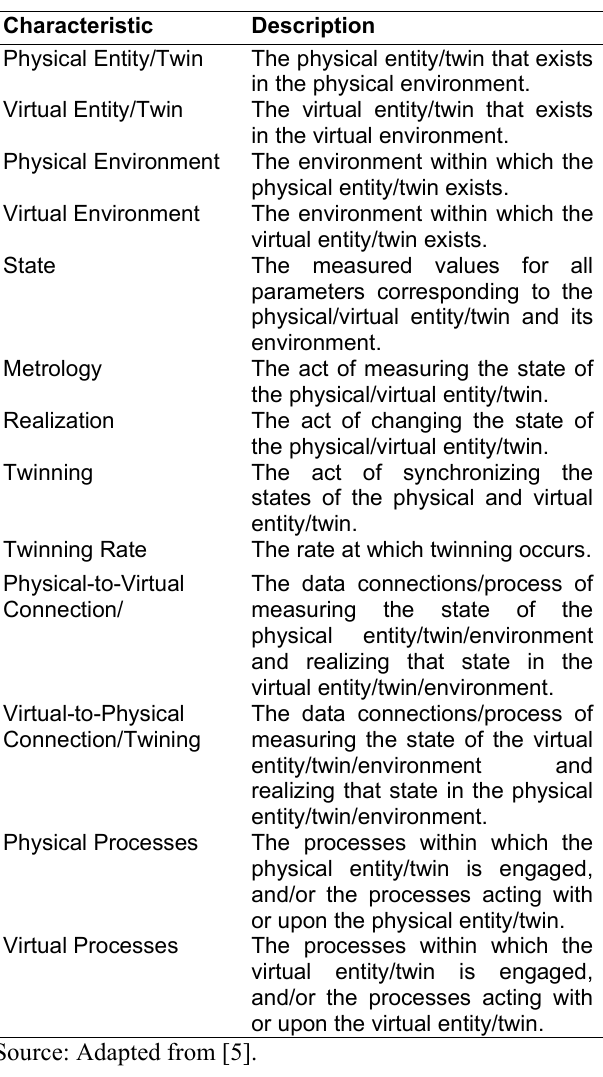
Table 2. Characteristics of the Digital